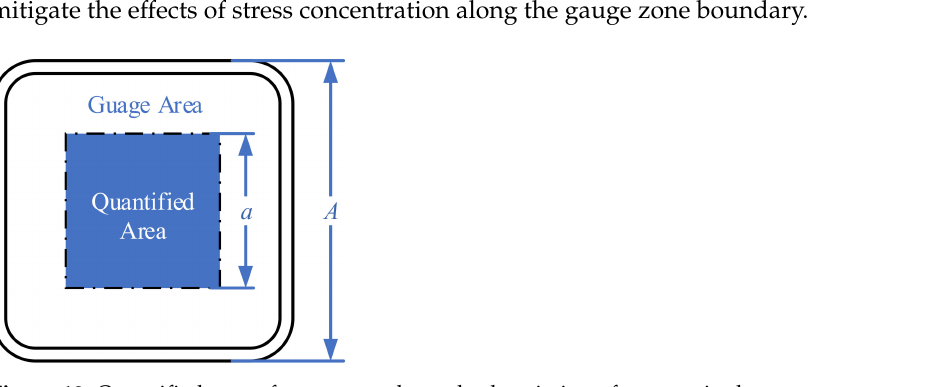
Figure 10. Quantified area of average and standard variation of stresses in the gauge zone.